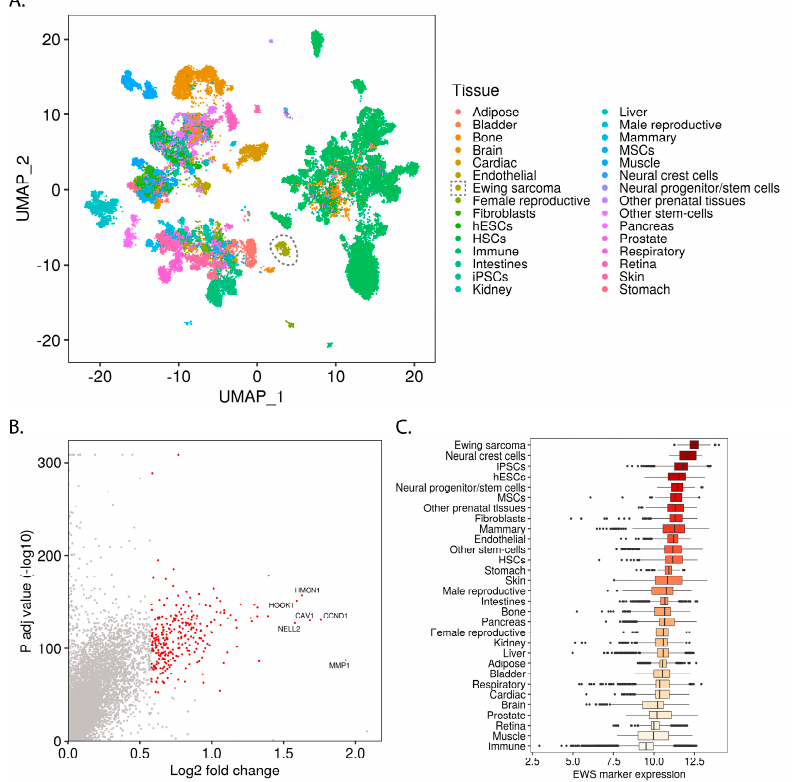
Figure 1. Mass-scale mining of bulk transcriptomes reveals the relationship of Ewing sarcoma to normal tissue types: ( A ) UMAP embedding of bulk transcriptomic profiles from normal tissues and Ewing sarcoma samples (Ewing samples circled); ( B ) One-way volcano plot showing the top Ewing sarcoma marker genes from Wilcoxon rank-sum testing with Bonferroni correction; ( C ) Box-plot comparing the Ewing sarcoma marker gene expression levels for different samples (median of variance stabilizing transform (VST) transformed and geometric mean normalized read counts for all Ewing sarcoma marker genes within each sample), grouped by tissue and ordered by median